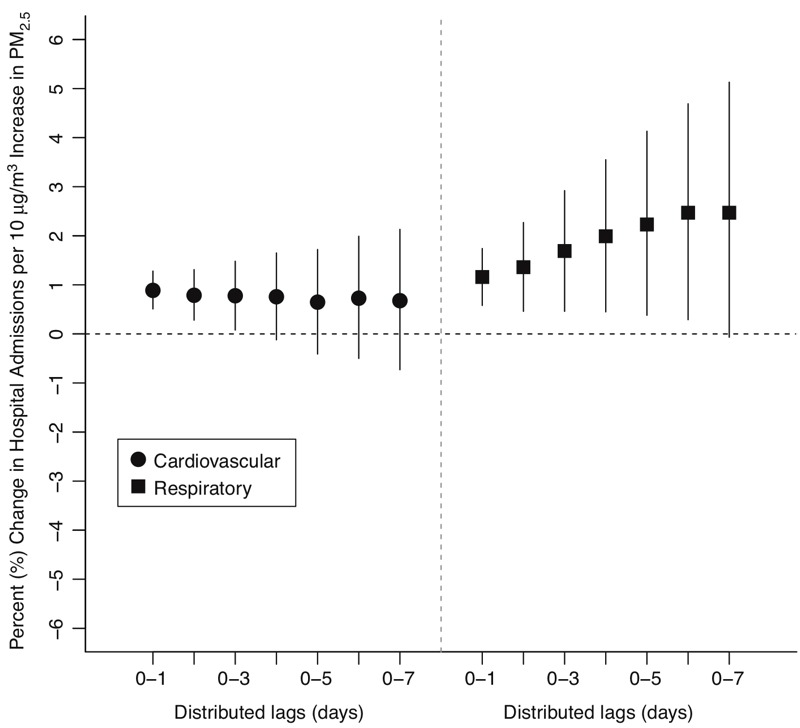
Percent increase in hospital admissions associated with a 10 μg/m3 increase in fine particulate matter (PM2.5) concentration, estimated for short-term distributed lags, using Community Multi-scale Air Quality (CMAQds) exposure estimates. Vertical lines represent 95% posterior intervals.